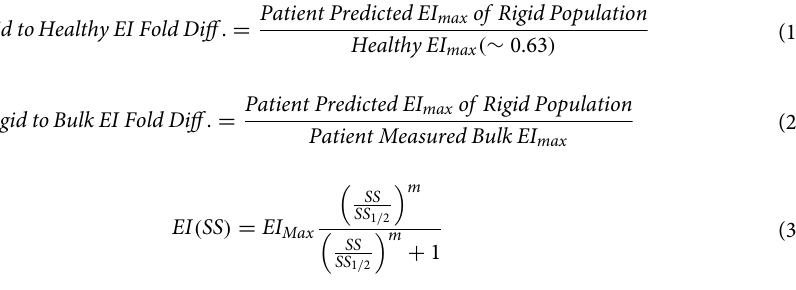
(1) Rigid to Healthy EI Fold Diff (2) Rigid to Bulk EI Fold Diff . = (3) EI ( SS ) = EI Max